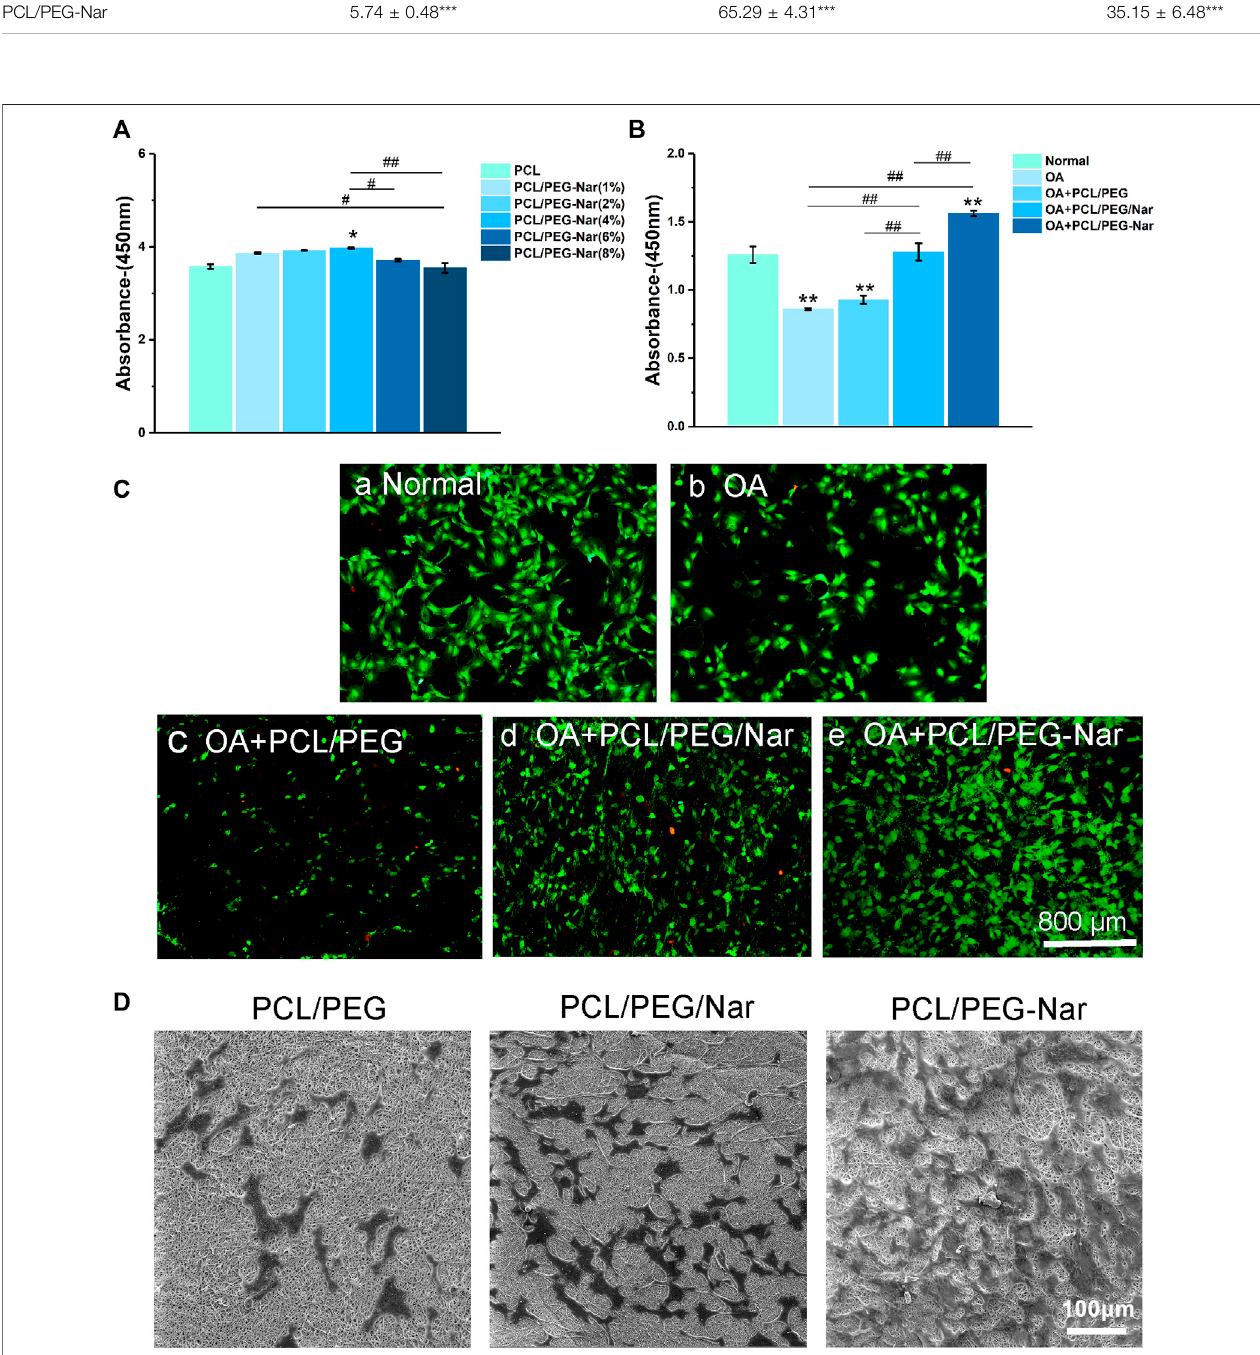
FIGURE 4 | Cell proliferation and viability of IL-1 β -stimulated chondrocytes on the nano fi ber membrane. (A) Cytotoxicity of chondrocytes cultured on different concentrations of PCL/PEG-Nar. (B) Proliferation of chondrocytes on PCL/PEG, PCL/PEG/Nar, and PCL/PEG-Nar after treatment with IL-1 β . (C) Cell viability of chondrocytes on PCL/PEG, PCL/PEG/Nar, and PCL/PEG-Nar after treatment with IL-1 β . (D) Morphology of chondrocytes on PEG/Nar, PCL/PEG-Nar, and PCL/PEG membranes.*indicates p < 0.05,**indicates p < 0.01,and***indicates p < 0.001comparedwiththenormalgroup; # indicates p < 0.05, ## indicates p < 0.01,and ### indicates p < 0.001 with comparison between